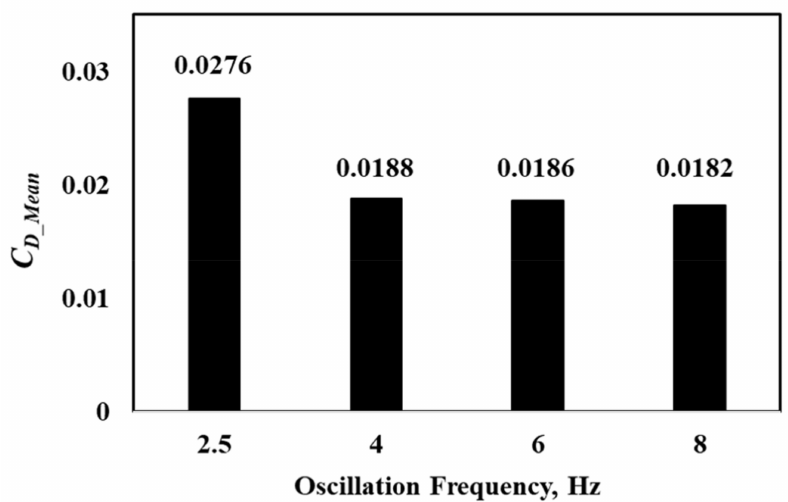
Figure 7. Variation of C D _ Mean with the oscillation frequency with no